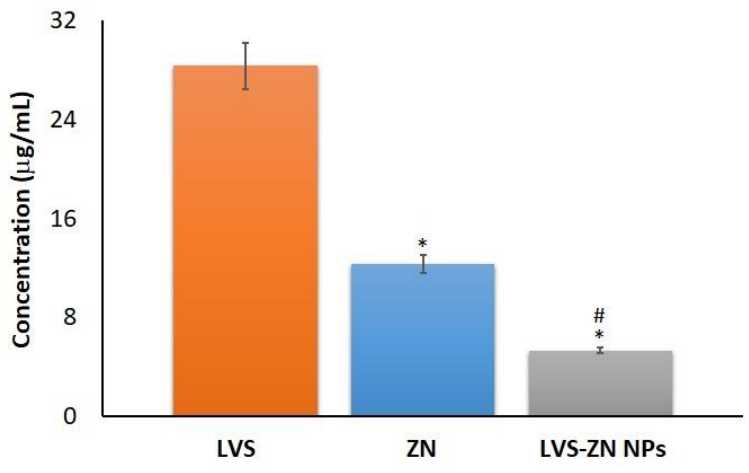
Figure 3. IC 50 of the raw LVS, ZN, and the LVS-ZN NPs in the HepG2 cell line. * Significantly di ff erent ( p < 0.05) compared to LVS. # Significantly di ff erent ( p < 0.05) compared to